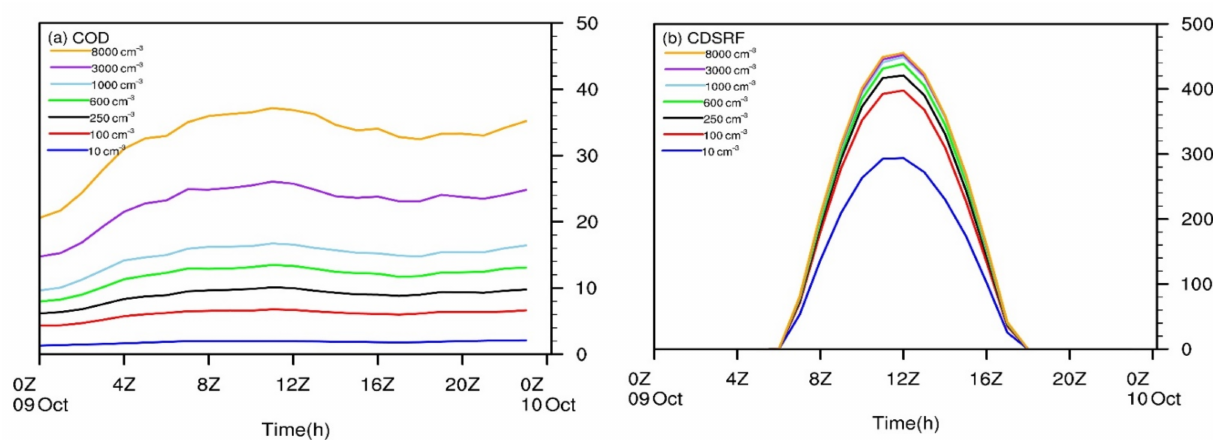
Figure 9. Hourly area-averaged COD ( a ) and CDSRF (W/m 2 ) ( b ) of Region A with different CCN 0 values from 00 UTC 9 to 00 UTC 10 October 2017.